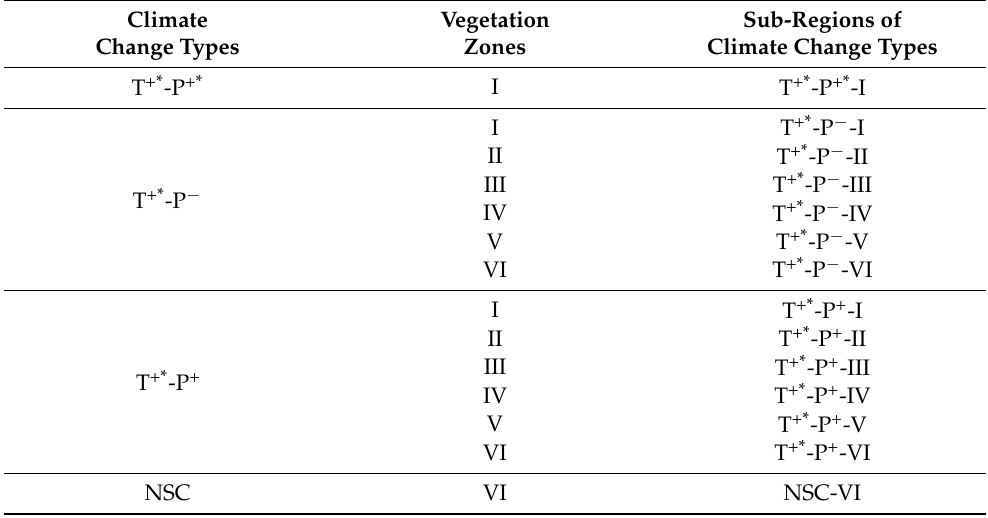
Table A3. Sub-regions of climate change types in Southwest China. Classification of vegetation zones: I, alpine vegetation region; II–V, respectively, represent the northwest region, west central region and northwest region of subtropical evergreen broad-leaved forest; and VI, tropical monsoon